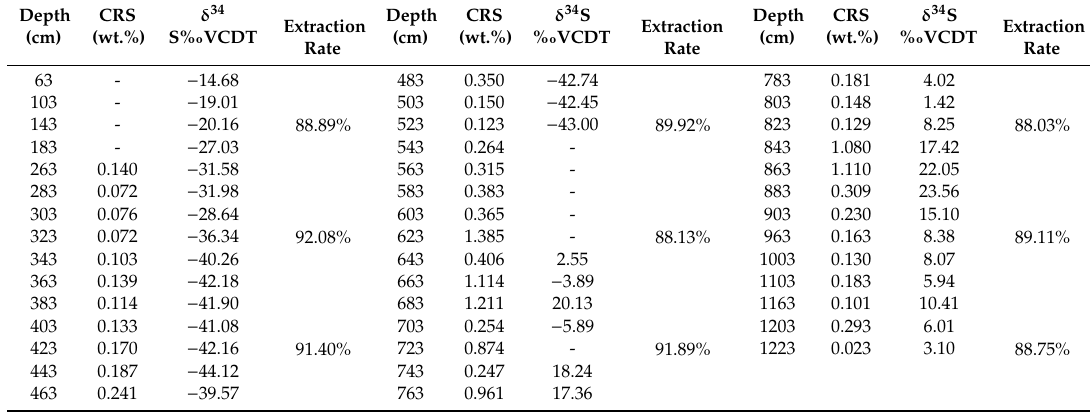
Table A1. CRS contents and the values of δ 34 S in sediment site